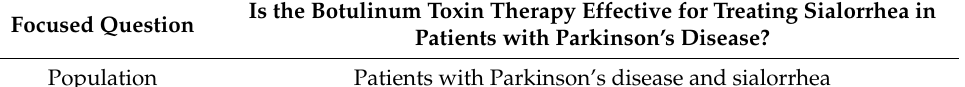
Table 1. Population, exposure and outcomes